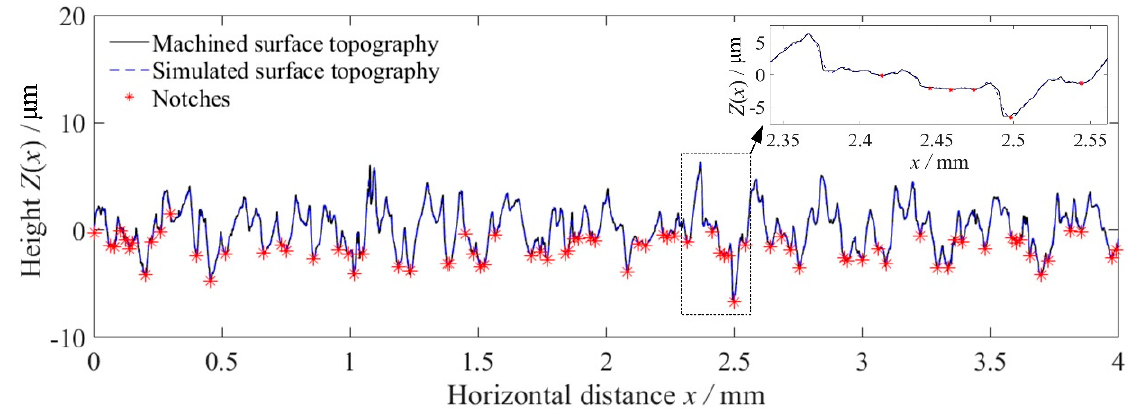
Figure 7. Machined surface topography and simulated surface topography for specimen B1.